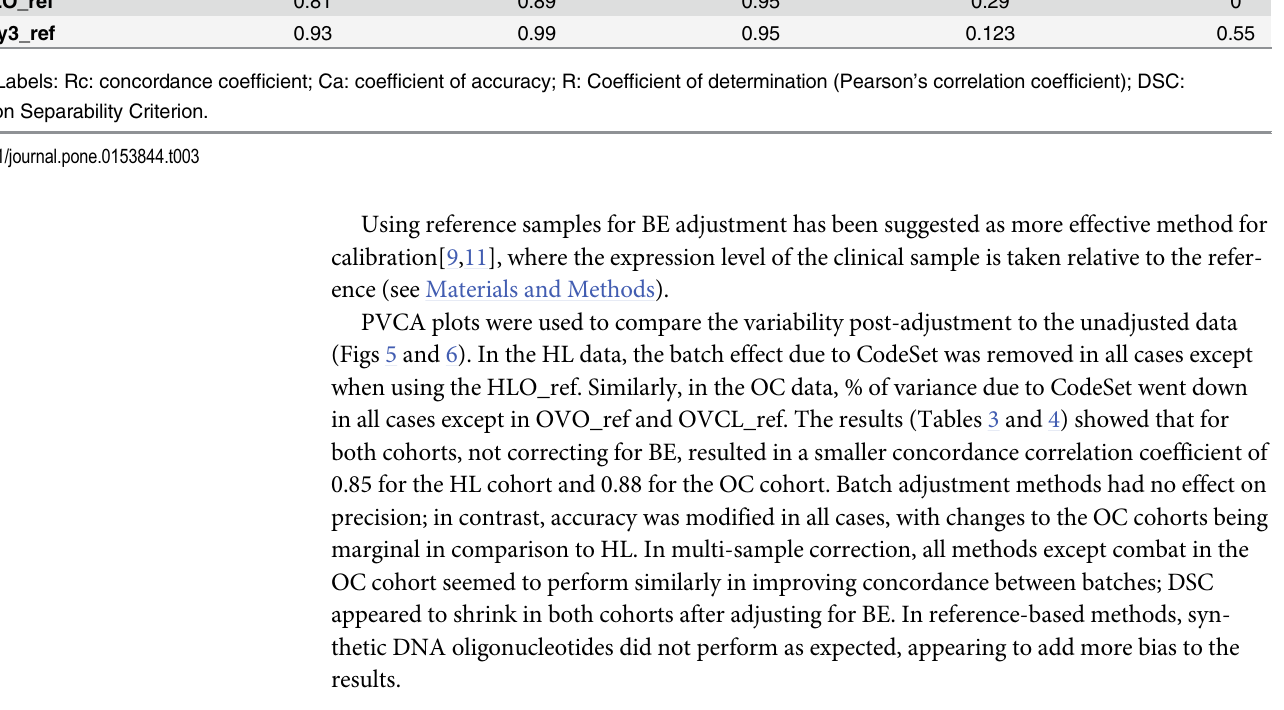
Table 4. Concordance between duplicates of OC clinical samples obtained from two CodeSets, after adjusting using different methods. Adjustment